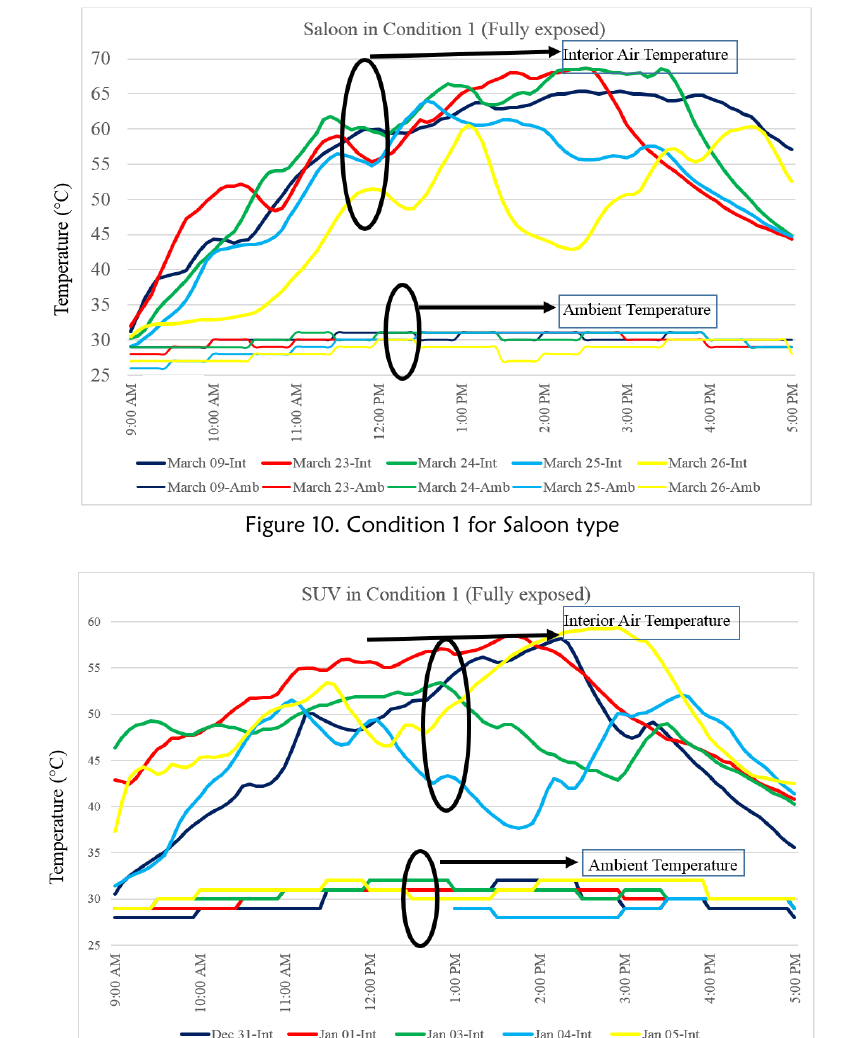
Figure 11. Condition 1 for SUV type